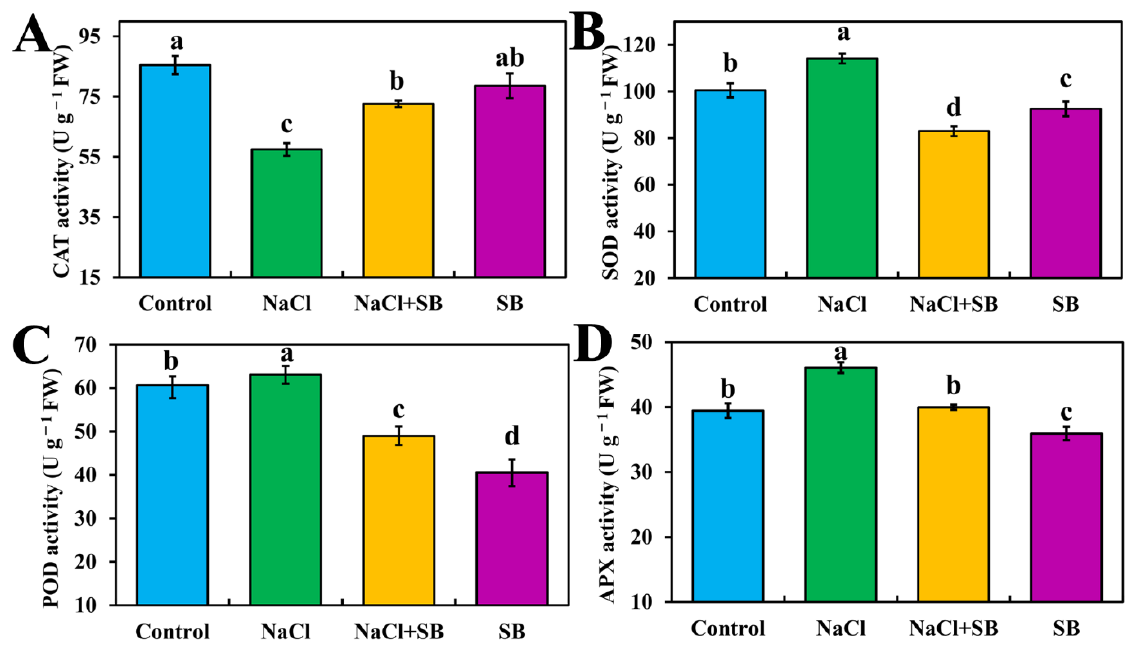
Figure 7. Effect of MAPK inhibitors SB203580 on the activities of antioxidant enzyme during salt stress. ( A ) CAT activity, ( B ) SOD activity, ( C ) POD activity, ( D ) APX activity. The values (means ± SE) are the averages of three-independent experiments ( n = 15). Bars not sharing the same letters indicate statistically significant differences according to Duncan’s multiple range test ( p <